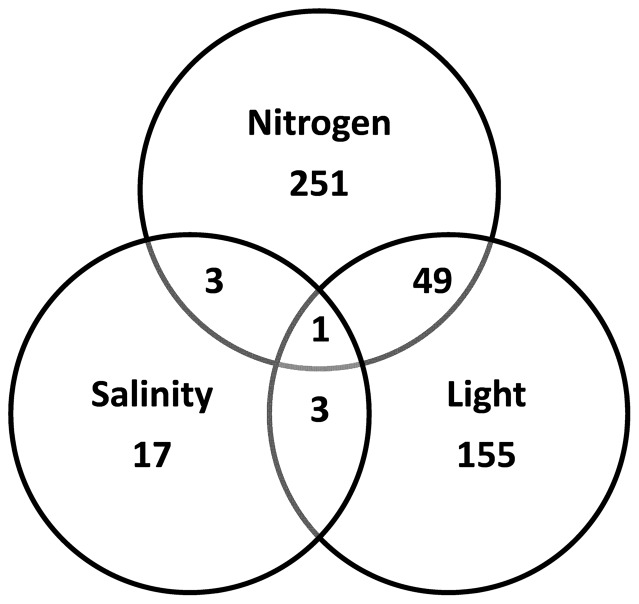
Global proteome changes.Venn diagram showing the number of protein spots identified by 2-dimensional gel electrophoresis, changing in relative abundance by more than 1.5-fold (t-test, FDR, q<0.05) in Thalassiosira pseudonana under nitrogen starvation, increased salinity and increased light intensity.